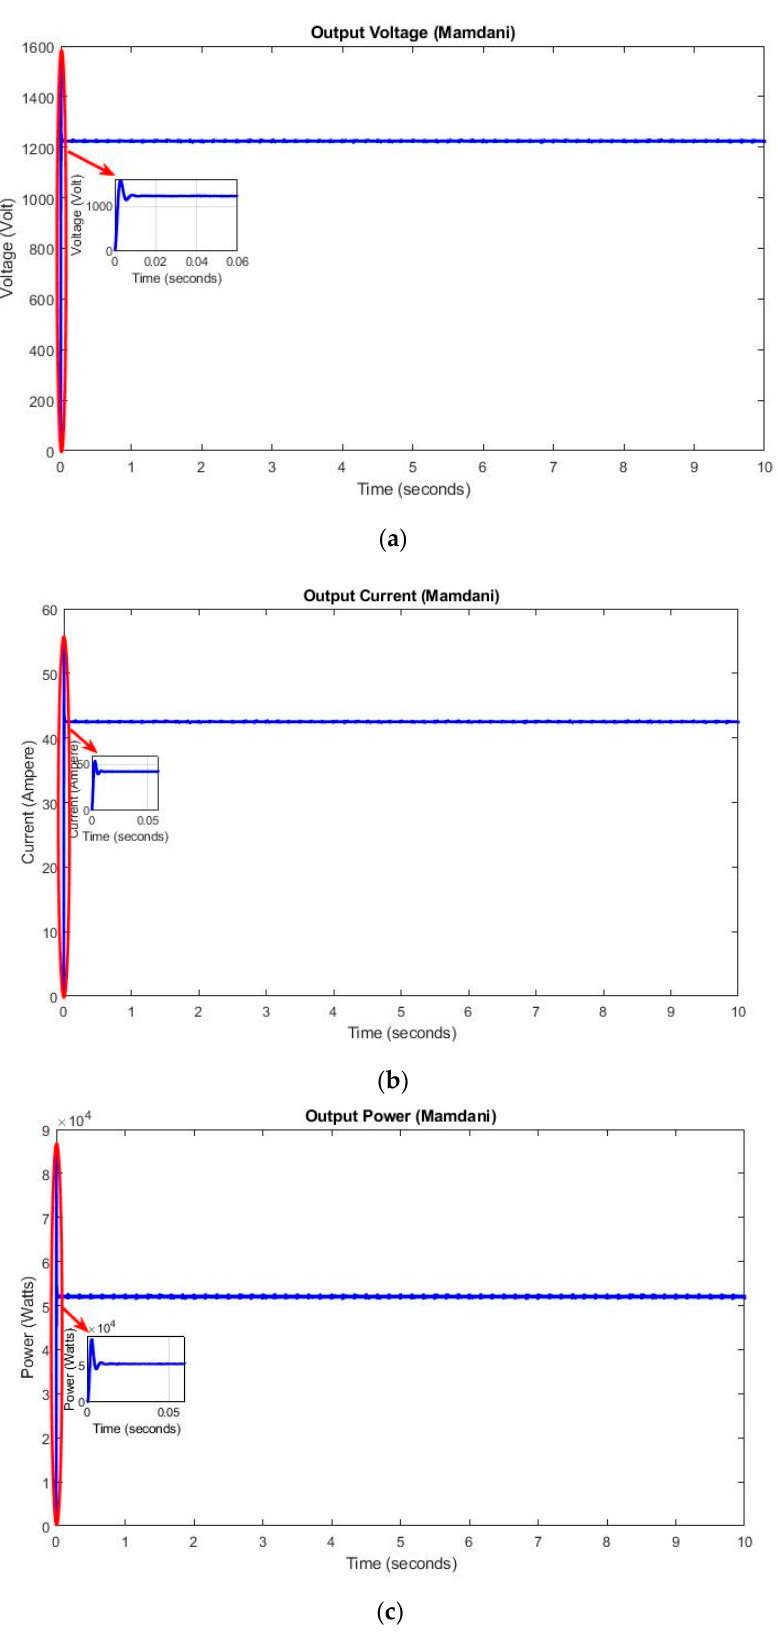
Figure 6. ( a ) Output voltage, ( b ) output current and ( c ) output power using the Mamdani Fuzzy Inference System.